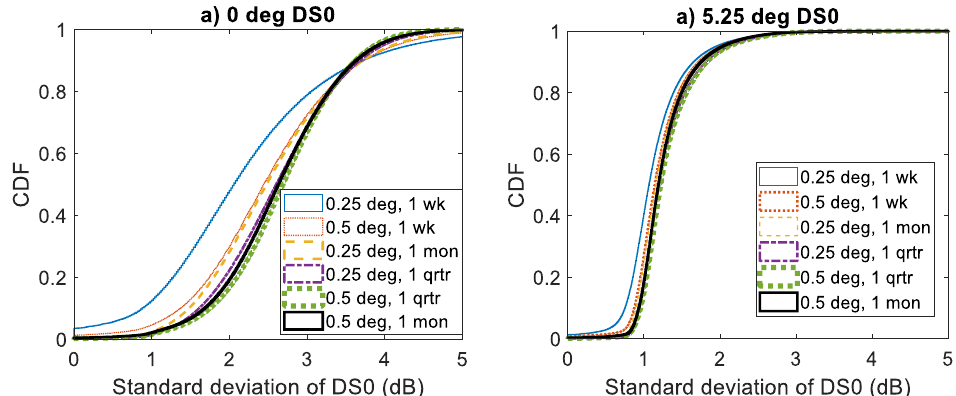
Figure 4. DS0 (Ku- minus Ka-band σ ◦ ) cumulative distribution function (CDF) for the SSD for different types and amounts of averaging. ( a ) CDF for nadir σ ◦ . ( b ) CDF for 5.25 ◦ incidence. Identical to Figure 2, except for DS0 rather than Ku-band. Horizontal axis is SSD.